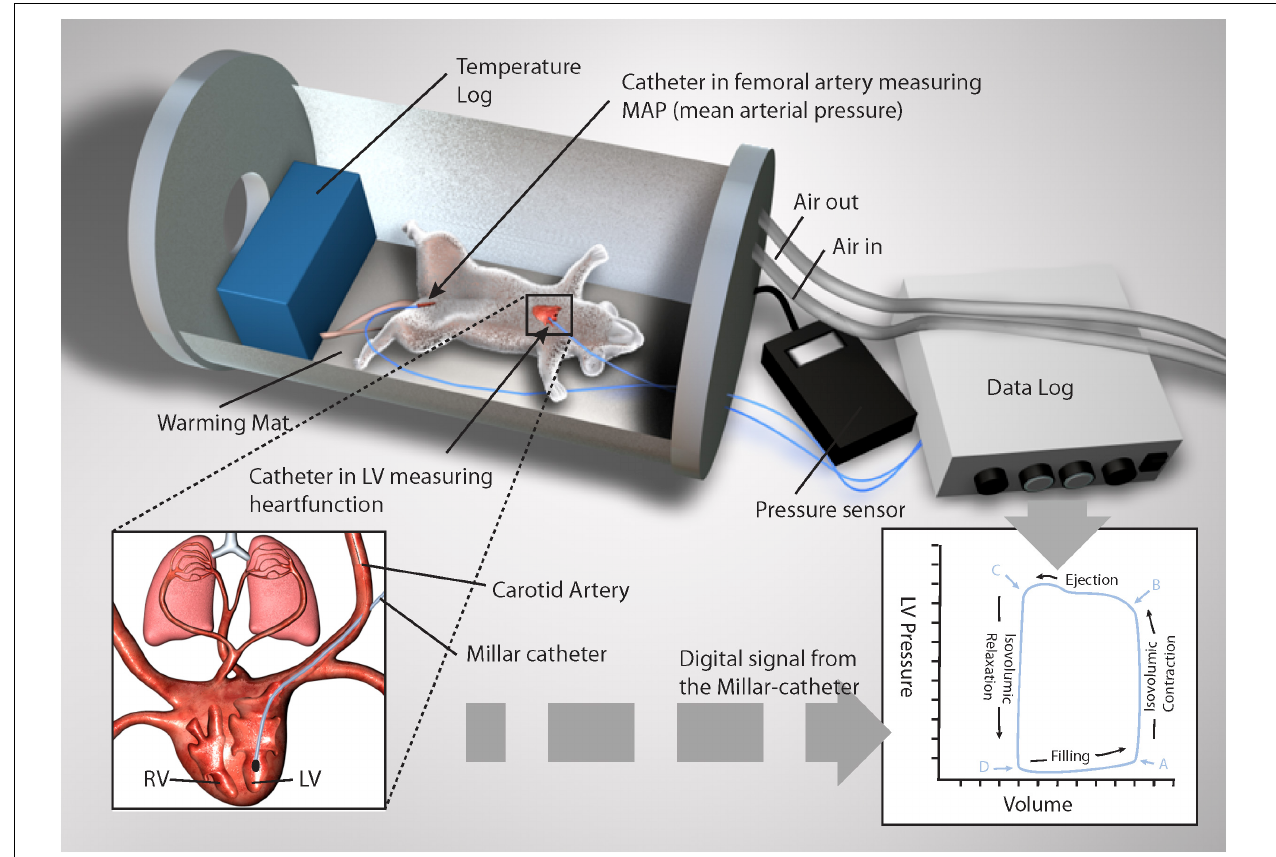
FIGURE 1 | Depiction of pressure volume loop (PV-loop) recordings in an anesthetized rat during simulated diving. A Millar catheter was inserted into the left ventricle and femoral artery. Illustration made on request by MGS